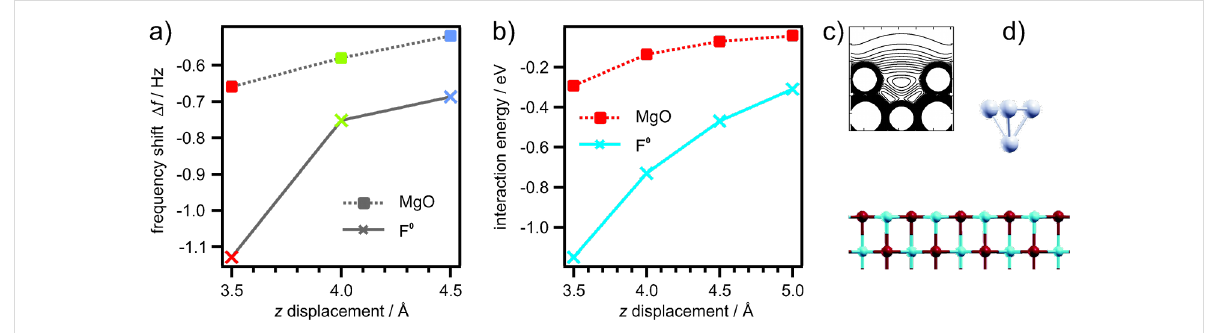
Figure 8: Dependence on tip-sample distance. a) Shift of the resonance frequency of a Pt 0.9 Ir 0.1 tip on a regular MgO surface (squares) and above an F 0 defect site (crosses). Experimental data are derived from the constant height measurements shown in Figure 7. The frequency shift is a direct consequence resulting from potential gradients between tip and sample. The integration of the frequency shift is related to the potential energy. b) Interaction energy of a Pt 4 cluster above the O site of an MgO surface (rectangles) and above an F 0 defect center (crosses) calculated by DFT. c) The spill over of the electron charge density of an F 0 center calculated by DFT. d) The Pt 4 cluster above the MgO surface [35,36].